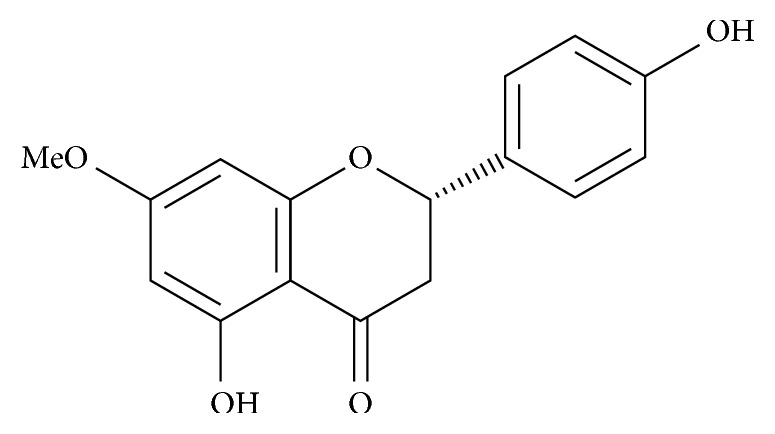
Sakuranetin structure, 5,4′-dihydroxy-7-methoxy flavanone, isolated from B. retusa.